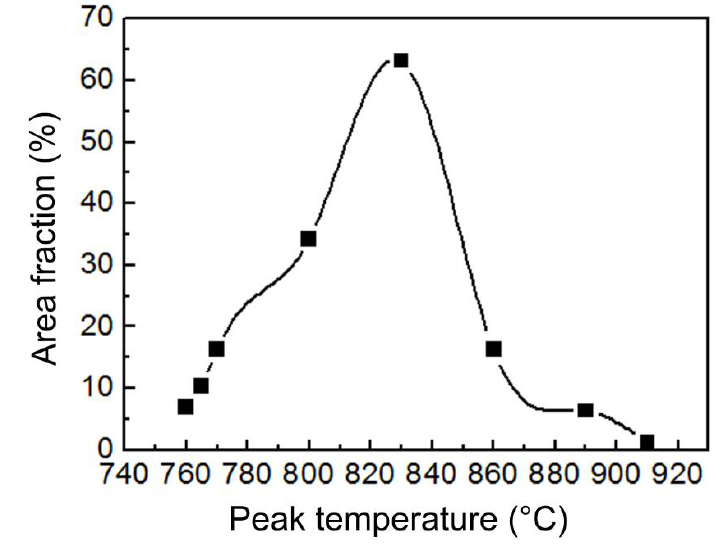
Figure 2. Area fraction of the M-A constituents in the IC HAZs as a function of peak temperature.